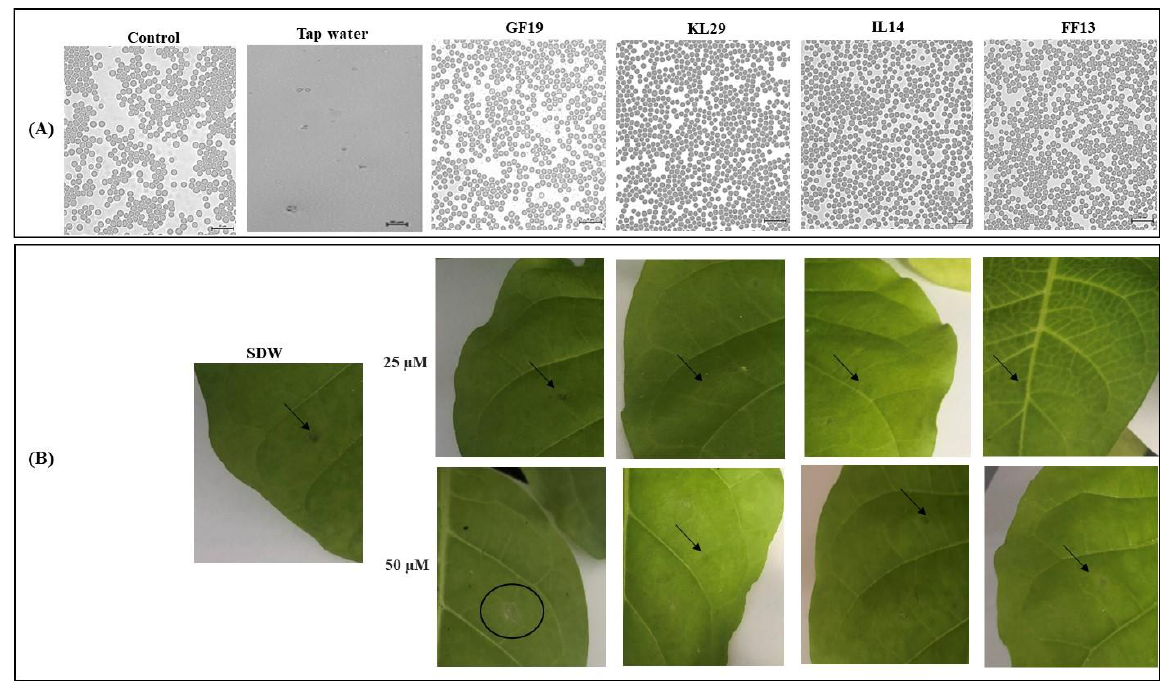
Figure 7. Micrographs showing ( A ) intact horse erythrocyte membranes and ( B ) non-lysed tobacco leaves challenged with different concentrations of AMPs for exploring their possible cytotoxicity. Control: untreated erythrocytes. Tap water-treated erythrocytes and sterile distilled water (SDW) injection in tobacco leaves were used as positive controls. Arrows show the AMP injection sites. A circle shows small leaf necrosis as a response to light hypersensitivity from GF19 at 50 μM. Bar: 20 µm.